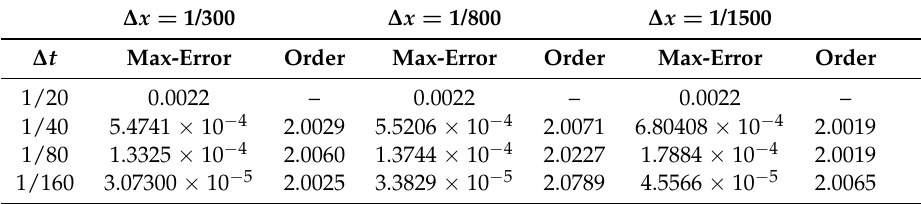
Table 2. Temporal convergence order taking fixed spatial step size with k = 0.1 and v = 1. ∆ x = 1/300 ∆ x =